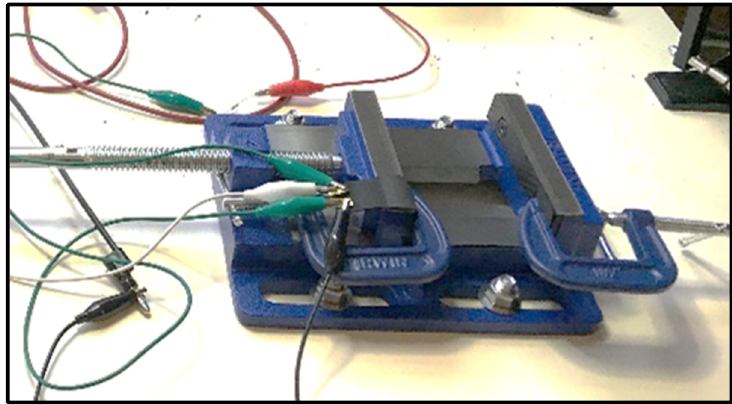
Figure 4. Drill vise fixture with SRS (Iteration I).